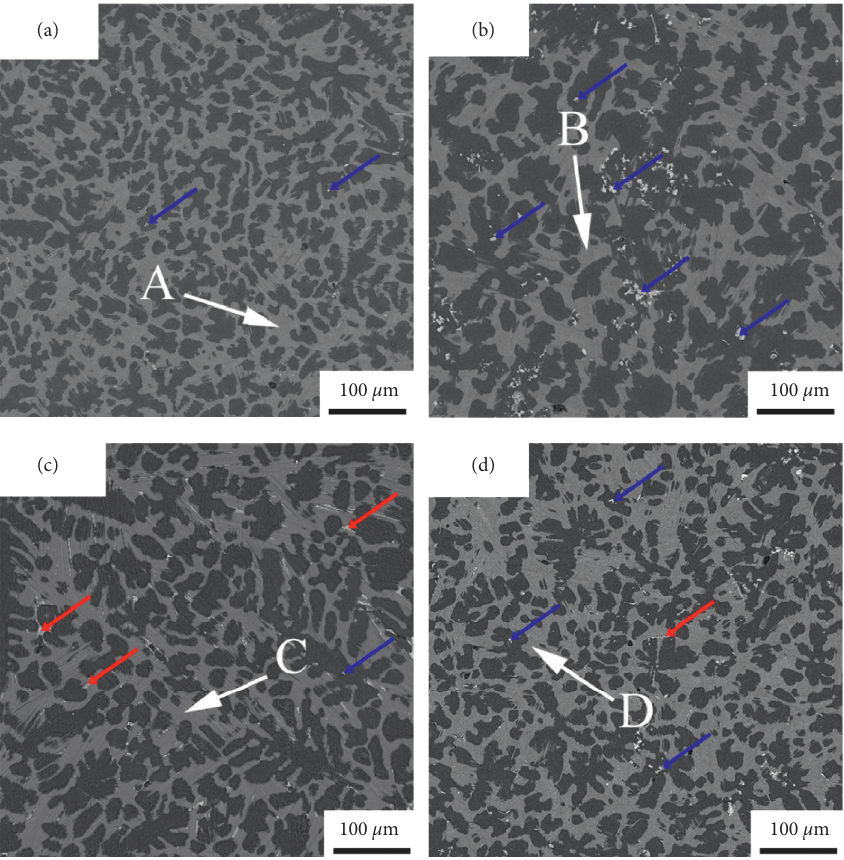
Figure 1: BSE images of as-cast (a) MYZ, (b) MYZC, (c) MYZN, and (d) MYZCN alloys.